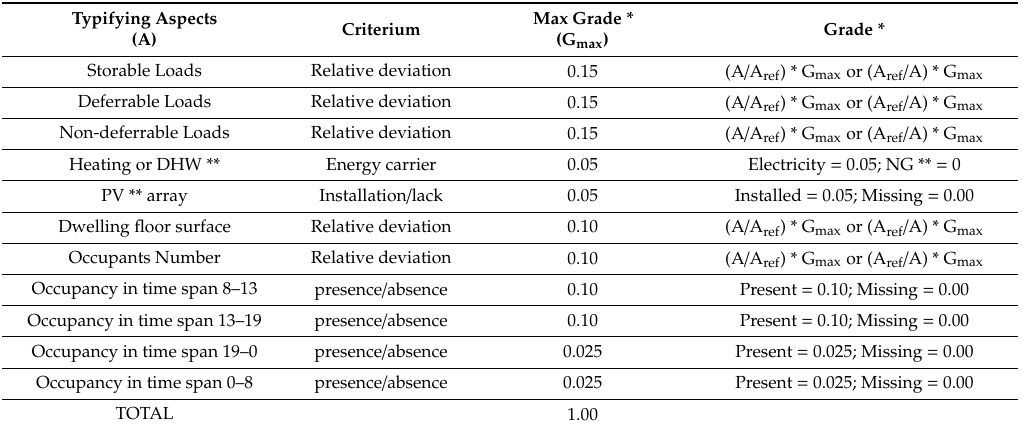
Table 1. Typifying Aspects and criteria outline for the Grade